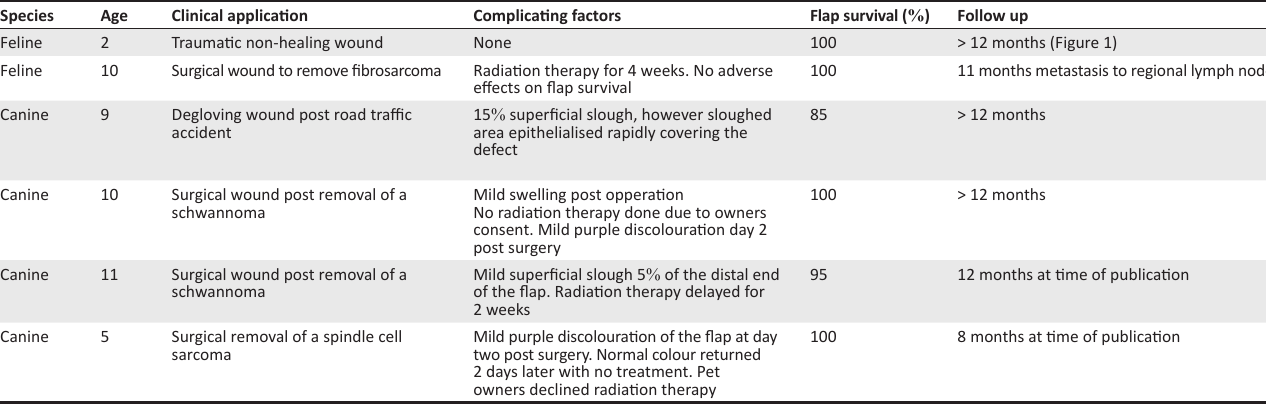
TABLE 1: Results of treatment of wound with reverse saphenous conduit flap. Species Age Clinical